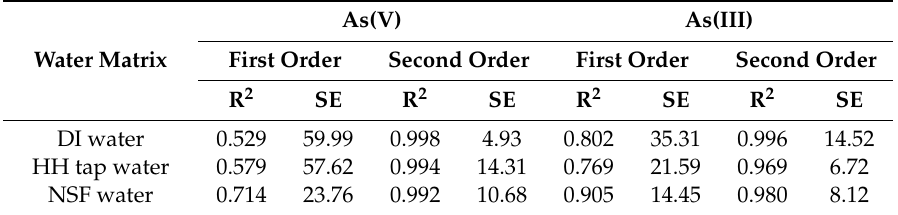
Table 5. Correlation coefficient (R 2 ) for the first- and second-order kinetic models, along with the standard error of estimation (SE).